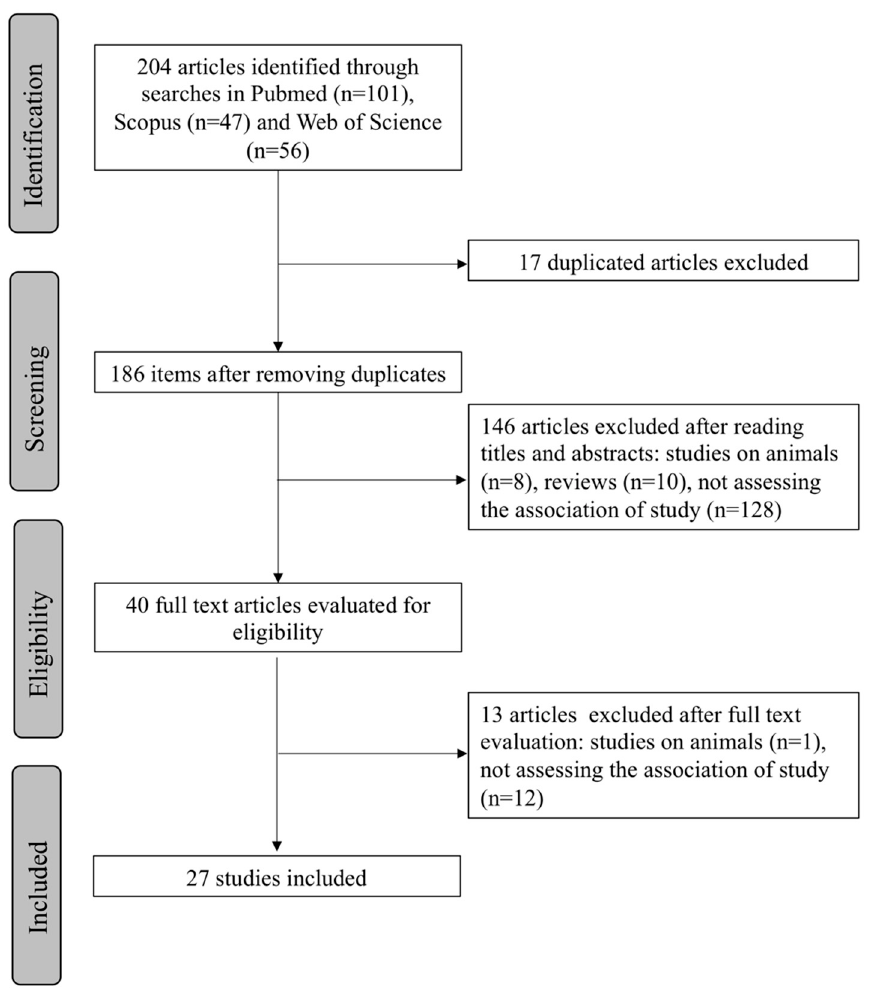
Figure 1. PRISMA flowchart showing the process of article selection.